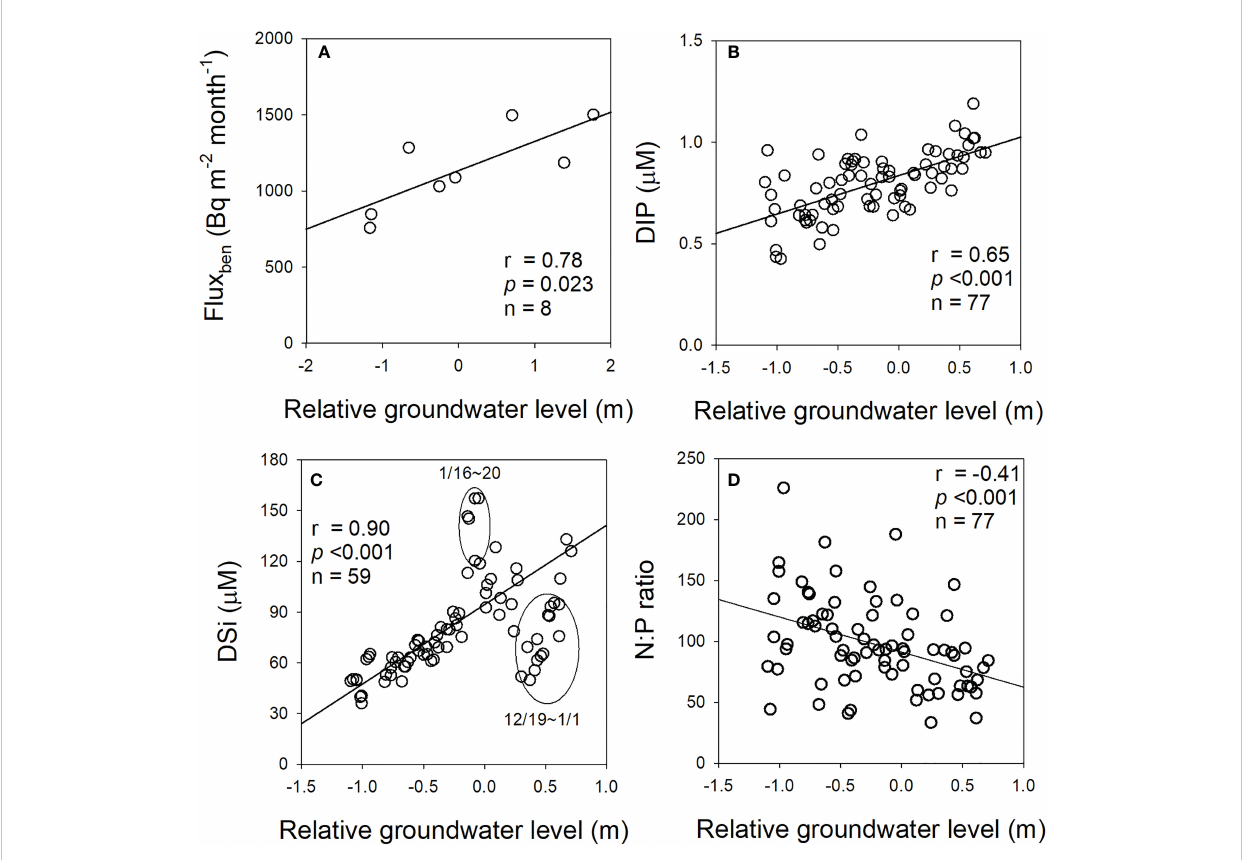
FIGURE 5 Plots of groundwater levels versus (A) benthic fl ux, (B) DIP, (C) DSi, and (D) N:P ratio. The values used for (A) are the monthly averages during the entire measurement period; the daily averages for (B – D) are from 16 December 2014 to 10 March 2015. The two circles in (C) are excluded from the regression line (solid